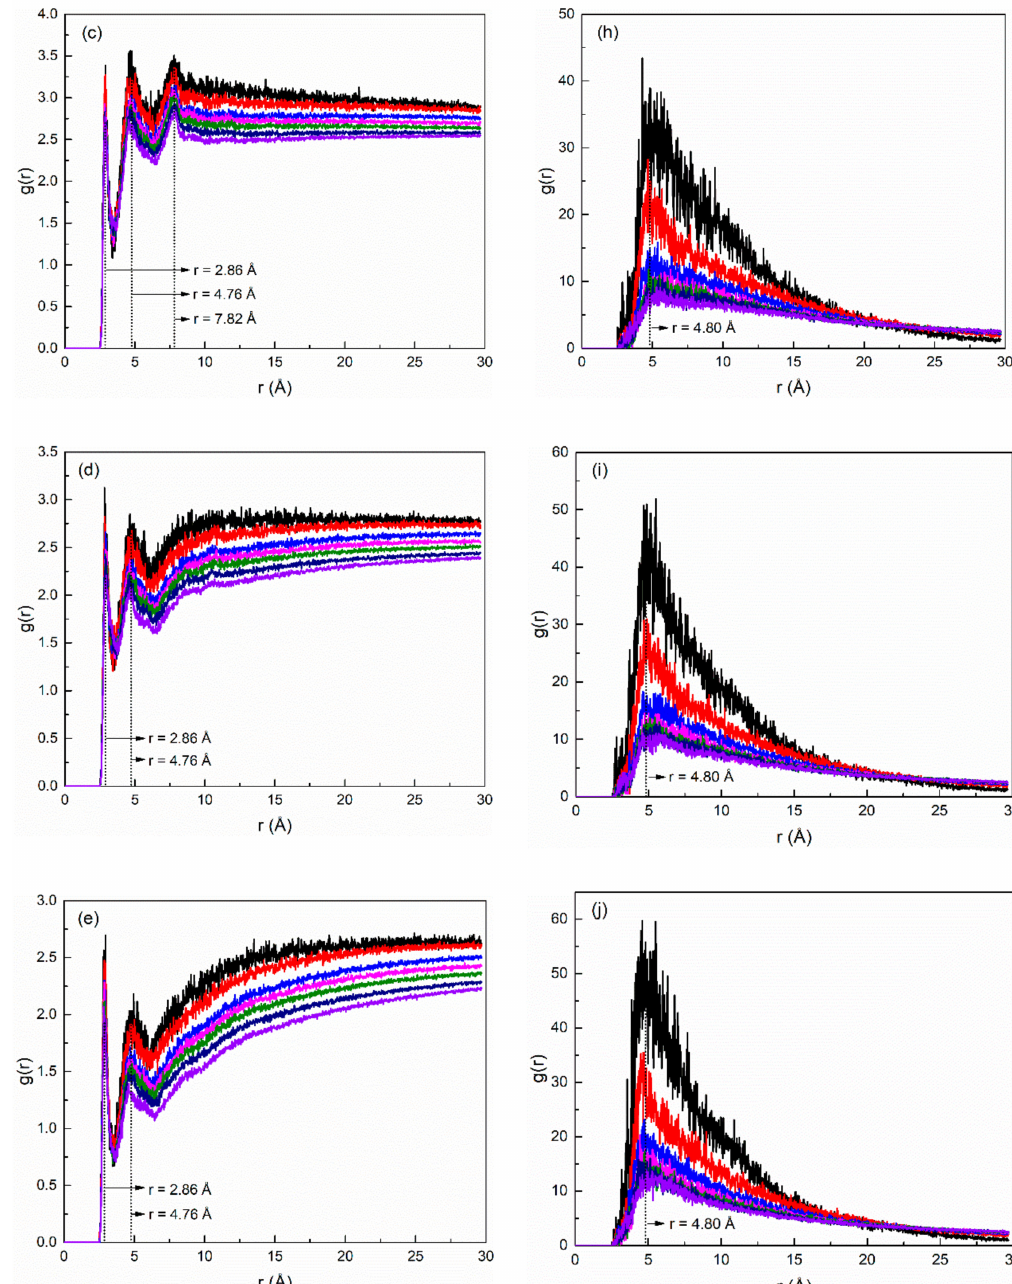
Figure 14. Radial distribution functions of water atoms (represented by their oxygen atoms) and PVA (represented by its oxygen atoms) around di ff erent oxygen atoms of surfactant in SDE 3 S / PVA